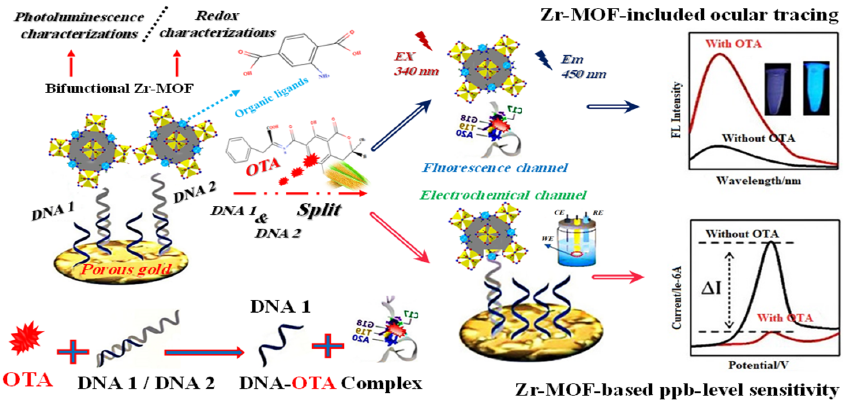
Figure 5. Graphical description of the dual-channel detecting of ochratoxin A (OTA). Adapted with permission from the article [67]. 2022, American Chemical Society.